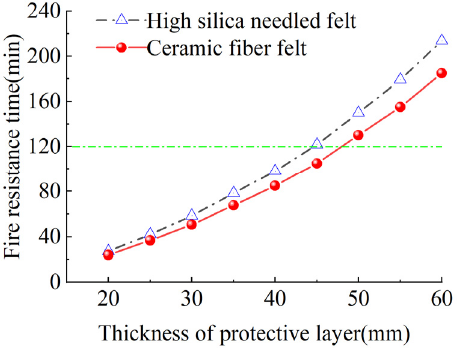
Figure 23. Critical duration of fire resistance duration.